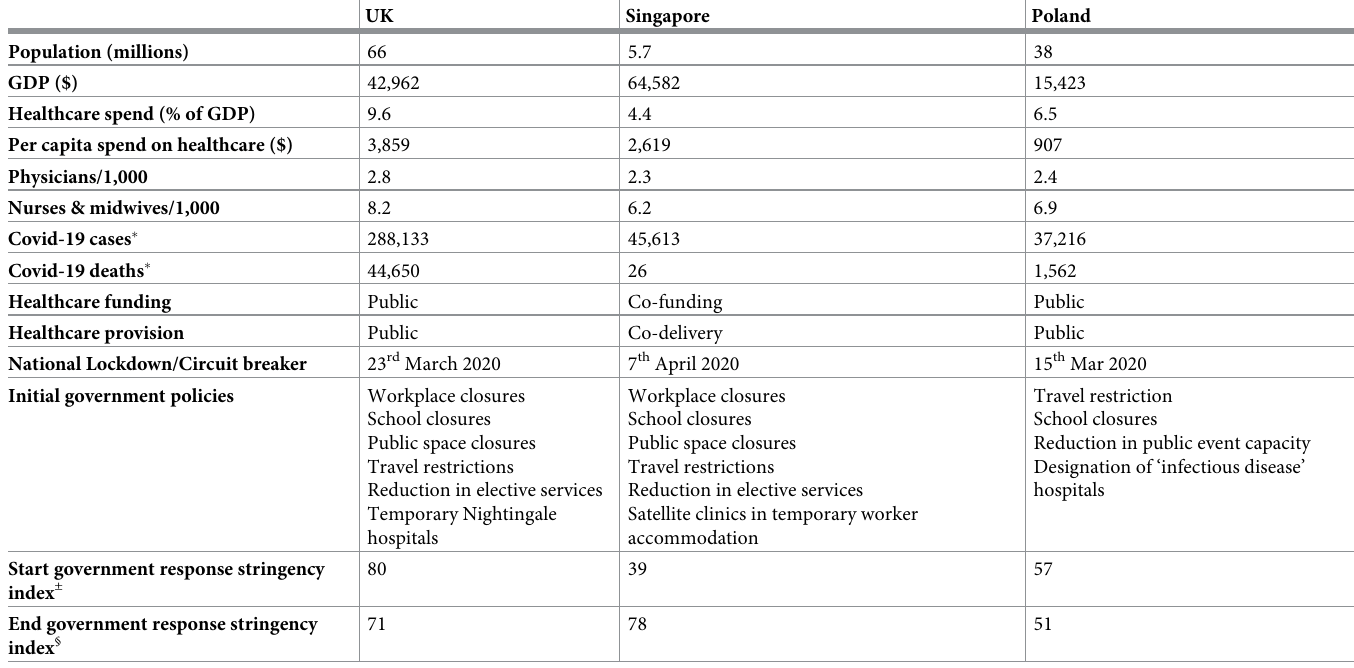
Table 1. Comparison of National Health Settings